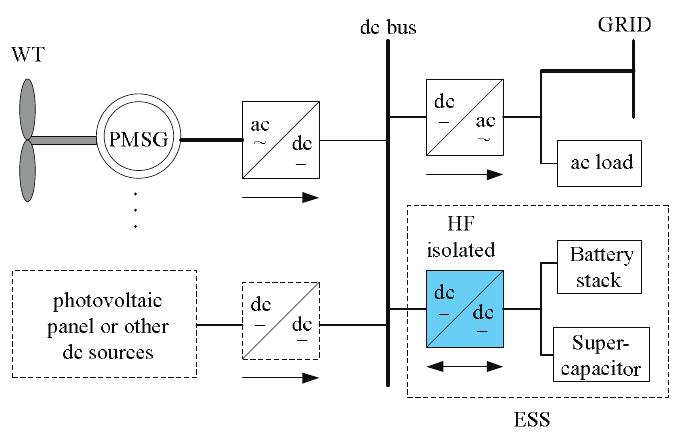
Figure 1. A hybrid renewable energy generation system equipped with